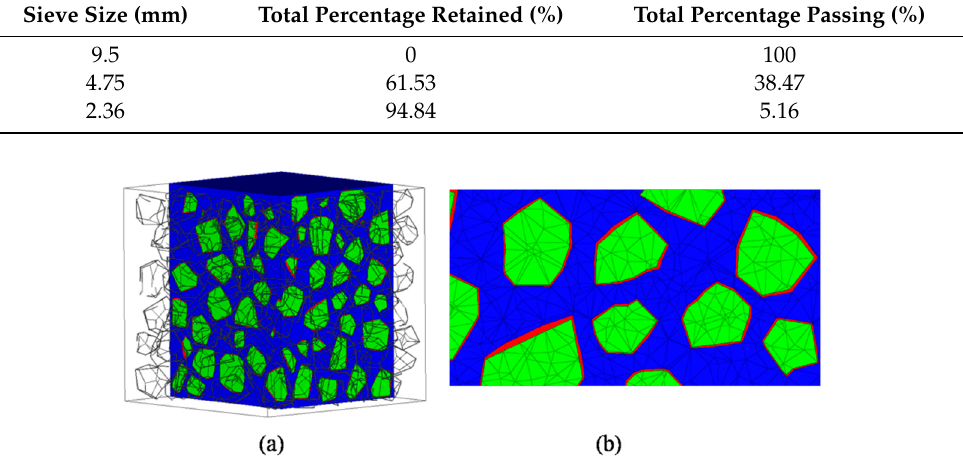
Figure13. Meshingresultsforconcretespecimen: ( a )Twocrossingplanescutview, ( b )localenlargement Figure 13. Meshing results for concrete specimen: ( a ) Two crossing planes cut view, ( b ) local cut enlargement cut view.